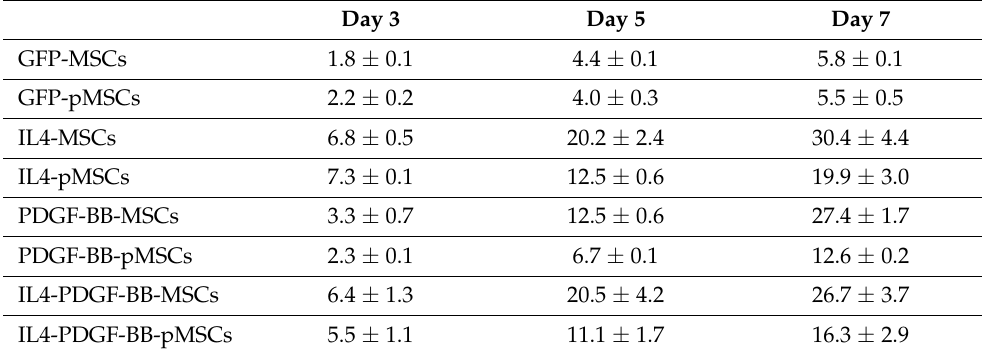
Table 1. Fold change in the amount of dsDNA compared to day